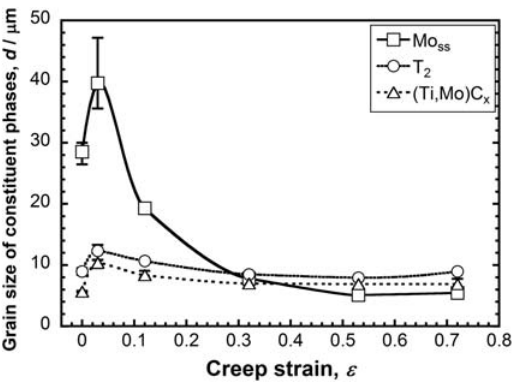
Figure 4: Changes in the grain size of constituent phases of the MoSiBTiC alloy as a function of the creep strain.